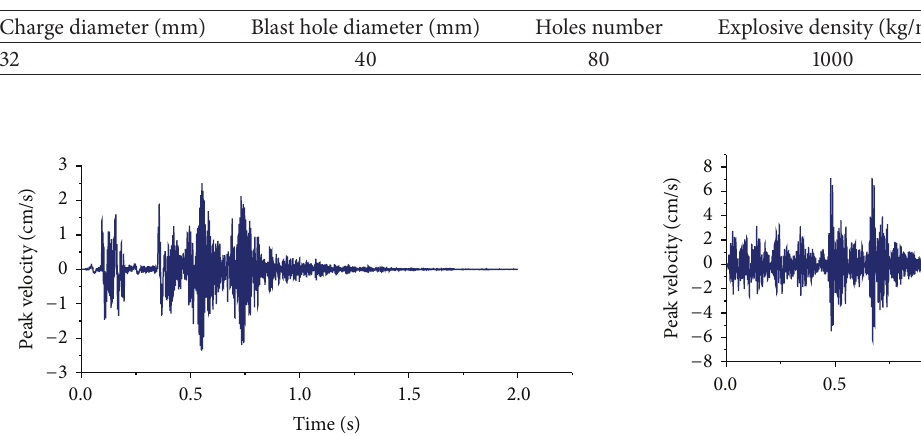
Figure 8: Simulated velocity curves in surrounding rock.